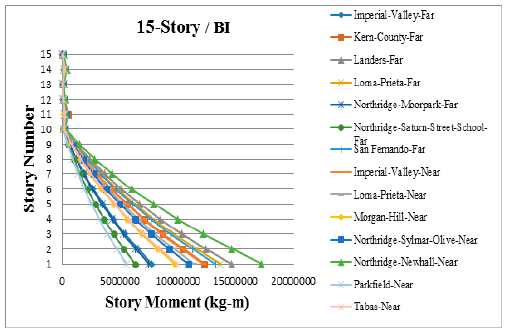
Figure A18. Peak story moments for 15-story base-isolated building.